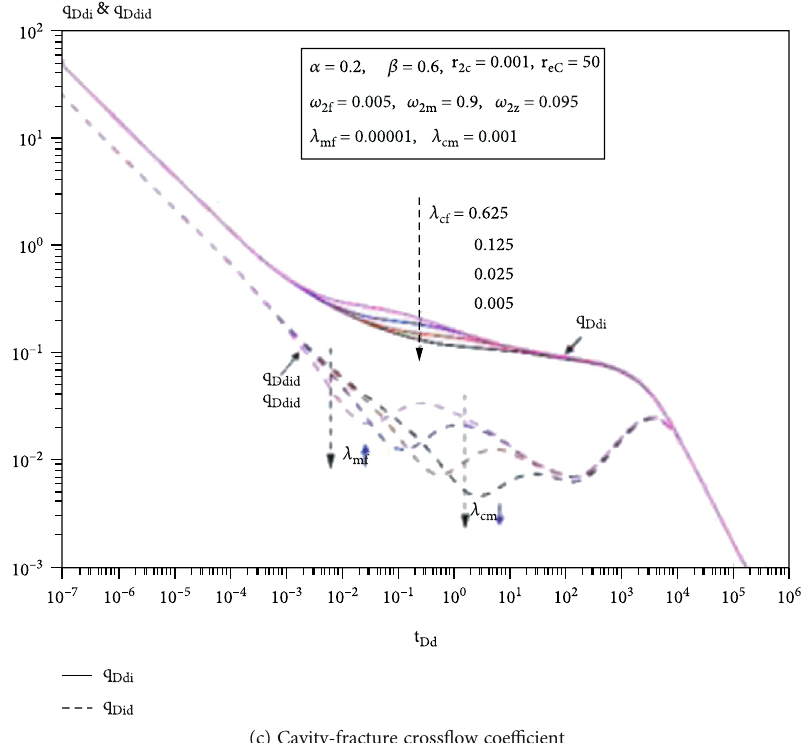
Figure 14: New rate decline curves of an AFVW in a pore-cavity-fracture carbonate reservoir under di ff erent cross fl ow coe ffi cients.